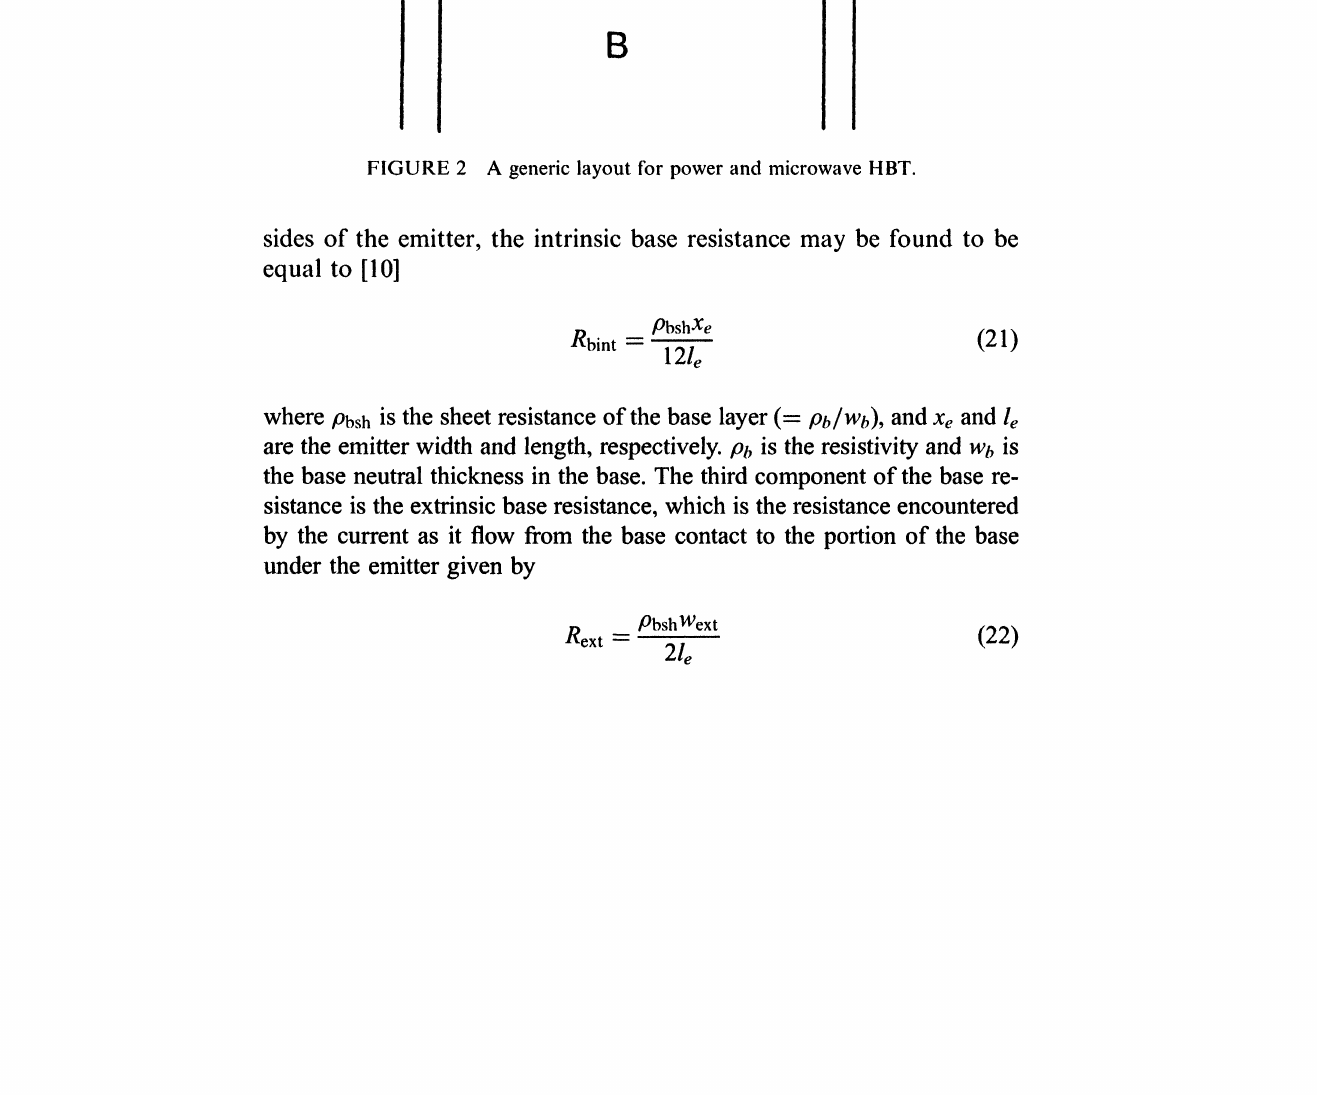
FIGURE 2 A generic layout for power and microwave